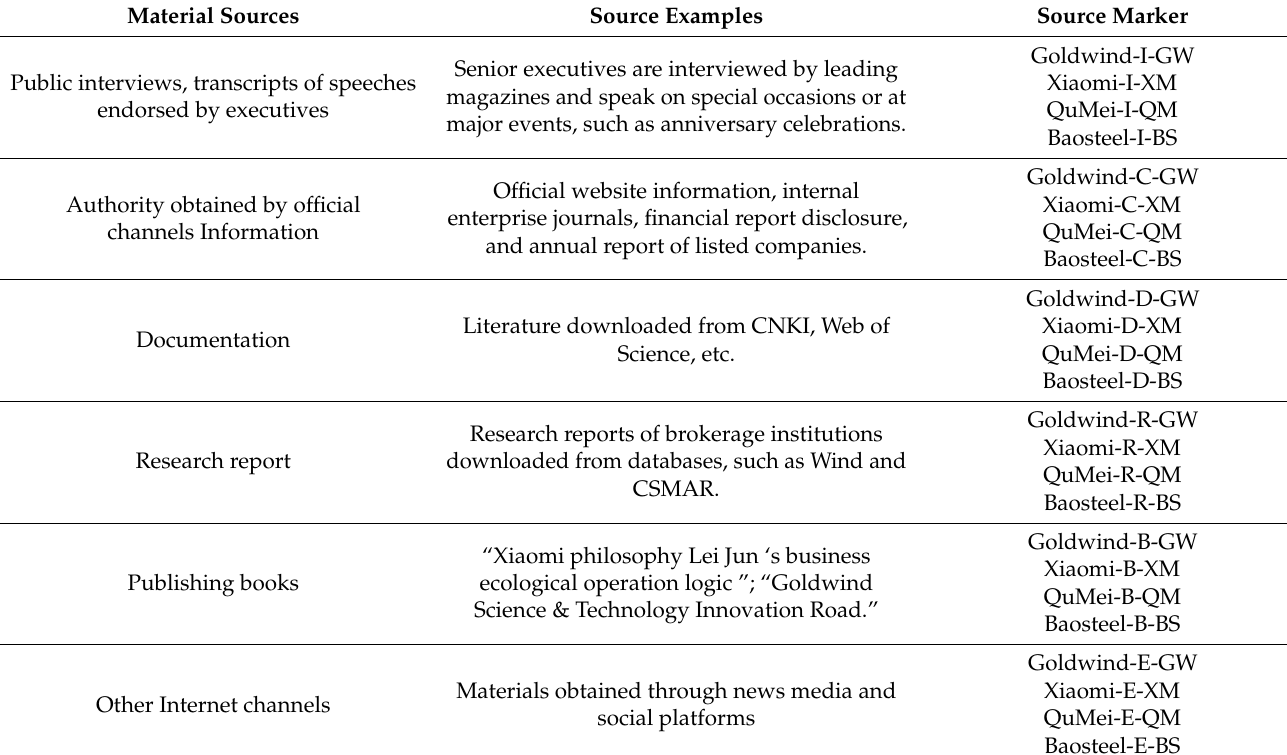
Table 2. Specific sources of case